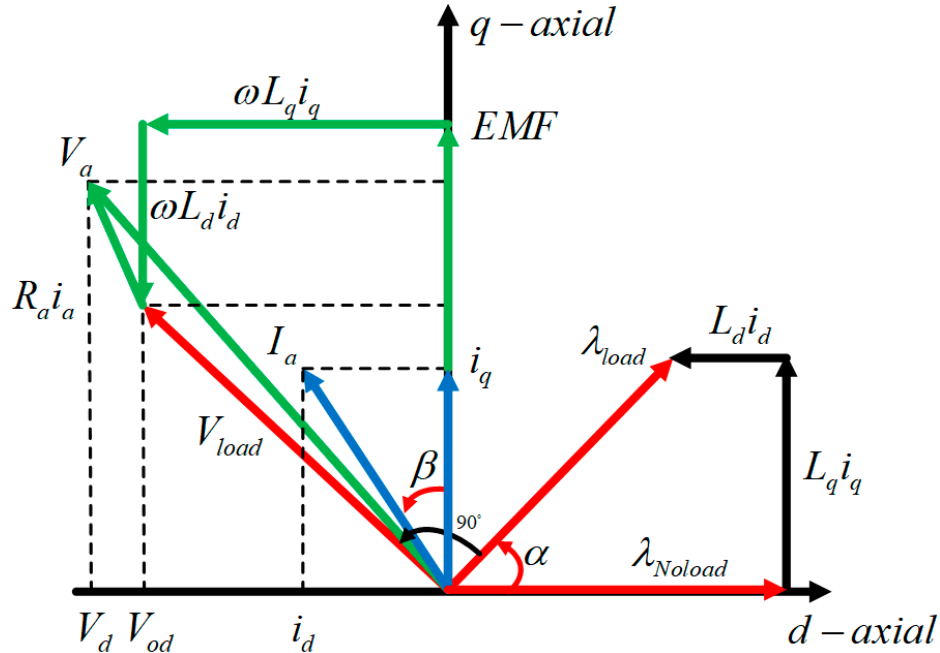
Figure 4. Vector diagram of IPMSM.